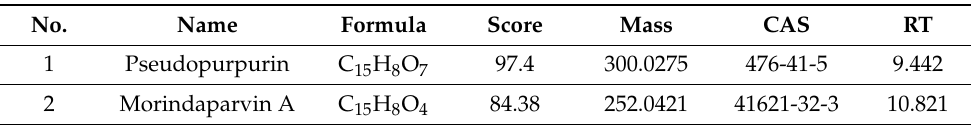
Figure 6. Chromatograms and structure (inset) of compounds identified by UPLC-UV-MS. Table 8. UPLC-UV-MS identification of major compounds from Rubia cordifolia L. root extract pre- pared in methanol. ID source: DBSearch.